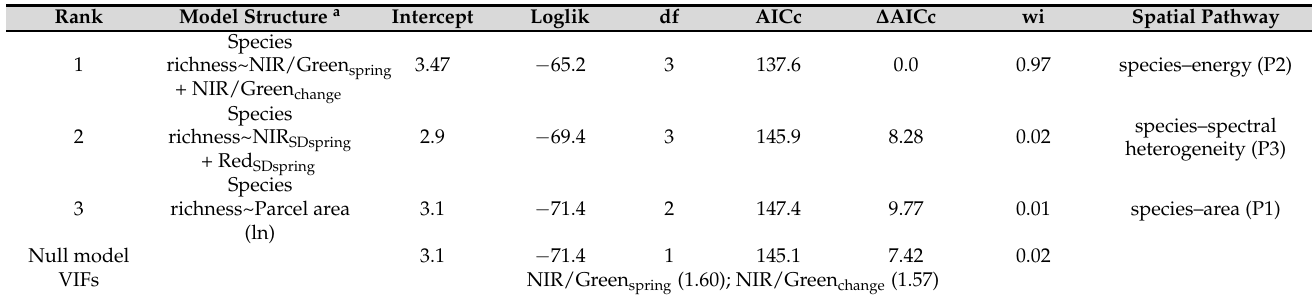
Table 1. Results of the multi-model selection approach with the three different spatial pathways evaluated to monitor plant species richness in the grassland parcels of Peneda-Ger ê s,